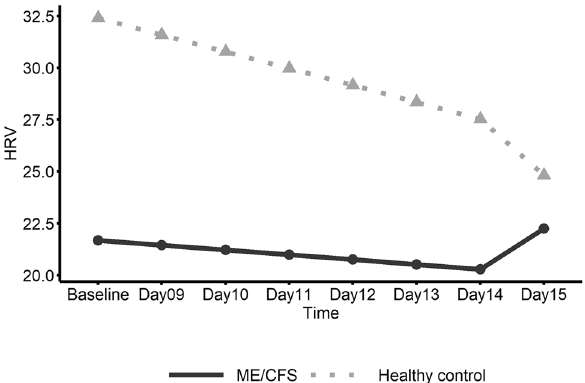
Figure 5. Linear trend of heart rate variability (HRV) for ME/CFS and healthy control groups. This graph shows daily heart rate variability (HRV) in ME/CFS and healthy control participants from pre-exercise Baseline (Days 1–8) to follow-up (Days 9–15) with the solid line representing the ME/CFS group and the dashed line representing healthy controls.